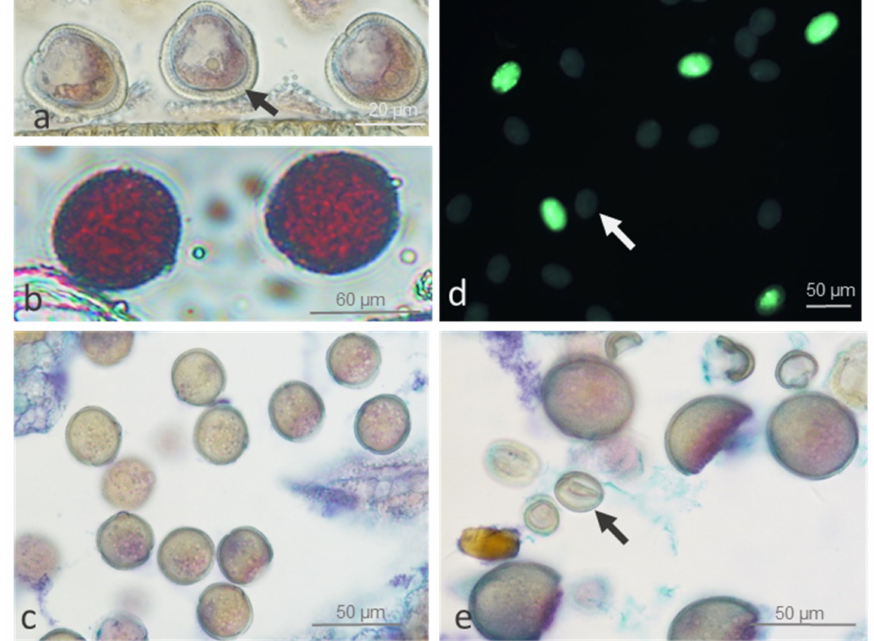
Figure 1. Viable and non-viable microspores and pollen grains of common buckwheat cv. ‘Panda’ and strain PA15 under control (20 ◦ C) and thermal stress (30 ◦ C) conditions. Vacuolated microspores of ‘Panda’ at 20 ◦ C with thick sporodermis ( a , arrow); viable pollen grains of PA15 at 20 ◦ C stained with Alexander dye ( b ) and at 30 ◦ C stained with Ehrlich’s hematoxylin combined with Alcian blue ( c ); and viable and non-viable (arrows) pollen grains of ‘Panda’ at 30 ◦ C stained with fluorescein diacetate ( d ) and at 20 ◦ C stained with Ehrlich’s hematoxylin combined with Alcian blue ( e ). At least 7900 pollen grains per treatment were analyzed in two